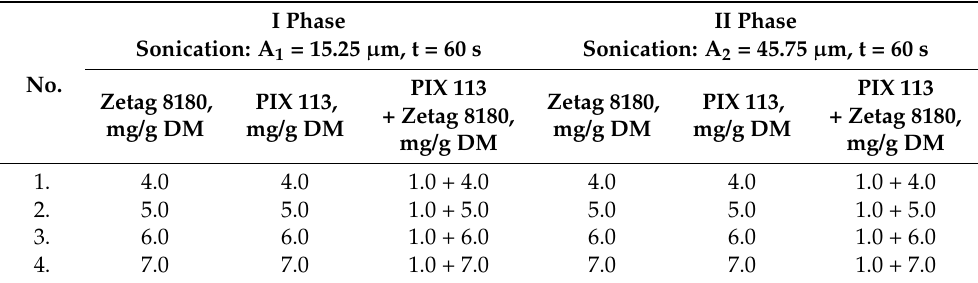
Table 2. Research stages.